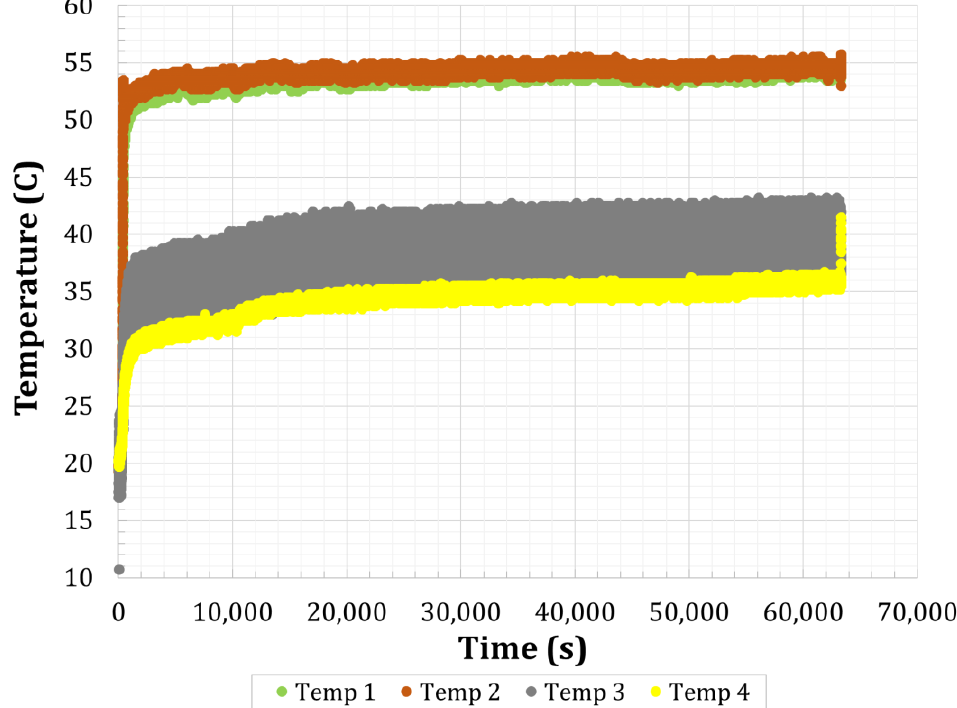
Figure 7. Antminer S17e heat exhaust over a 24 h period measured in degrees Celsius. Temperature 1 refers to heat exhausted from the top main fan of the Antminer. Temperature 2 refers to the heat exhausted from the bottom main fan of the Antminer.